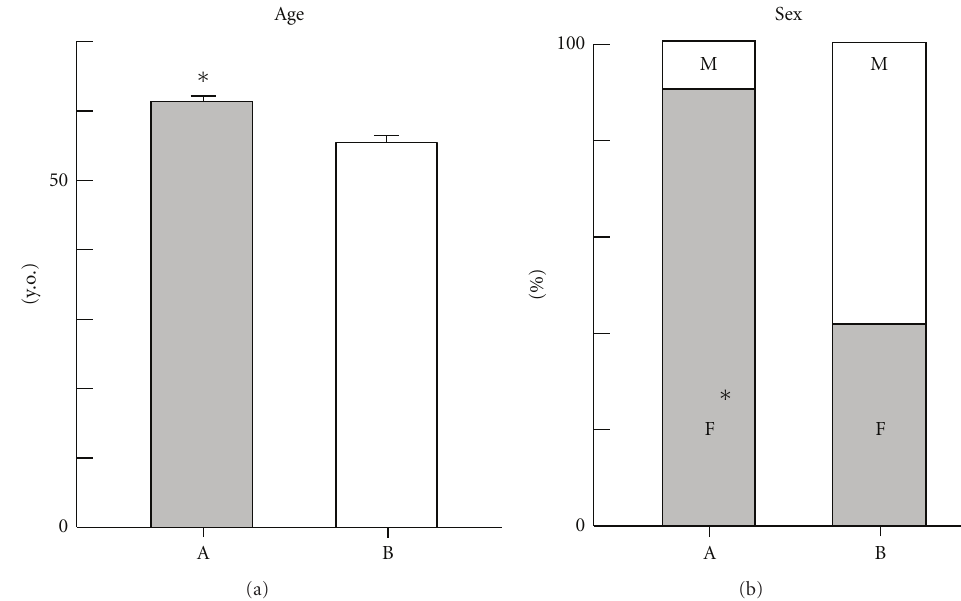
Figure 1: Clinical features (age, sex) of CHC patients. (a) patients who developed anti-TPO antibodies ( n = 10) at six months after the start of peg-interferon and ribavirin therapy. (b) Patients who not developed anti-TPO antibodies ( n = 40) at six months after the start of peg-interferon and ribavirin therapy. ∗ P < 0 . 05 was statistically